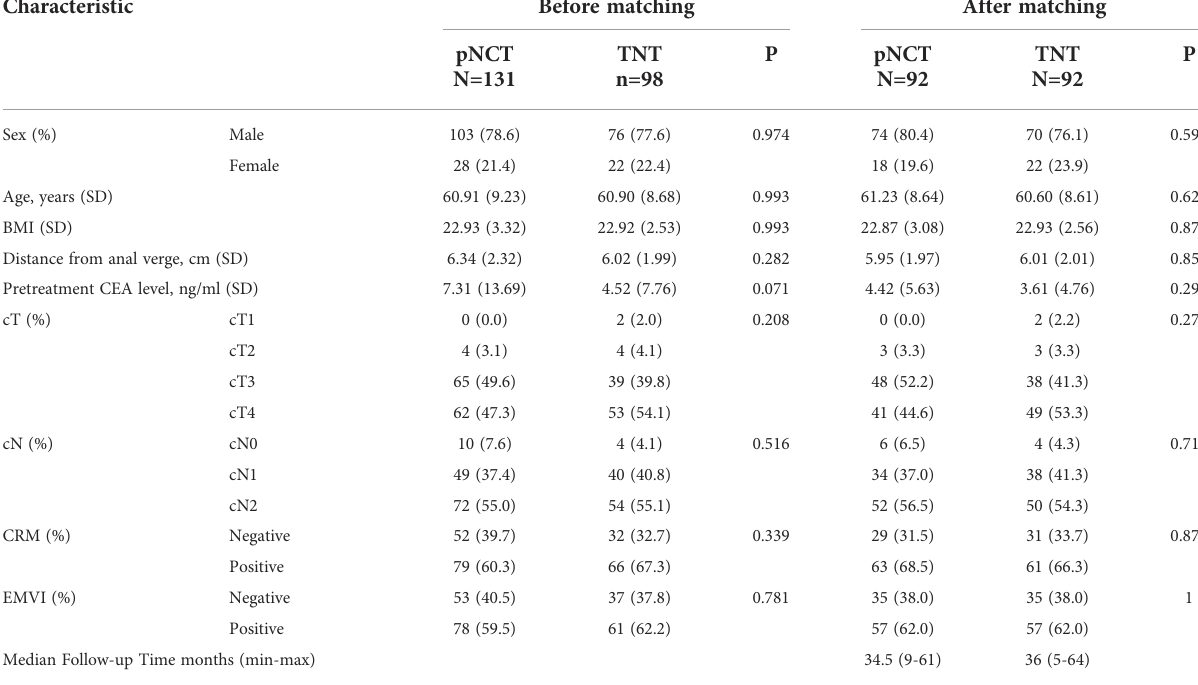
TABLE 1 Baseline clinical characteristics of patients before and after propensity scoring matching. Characteristic Before